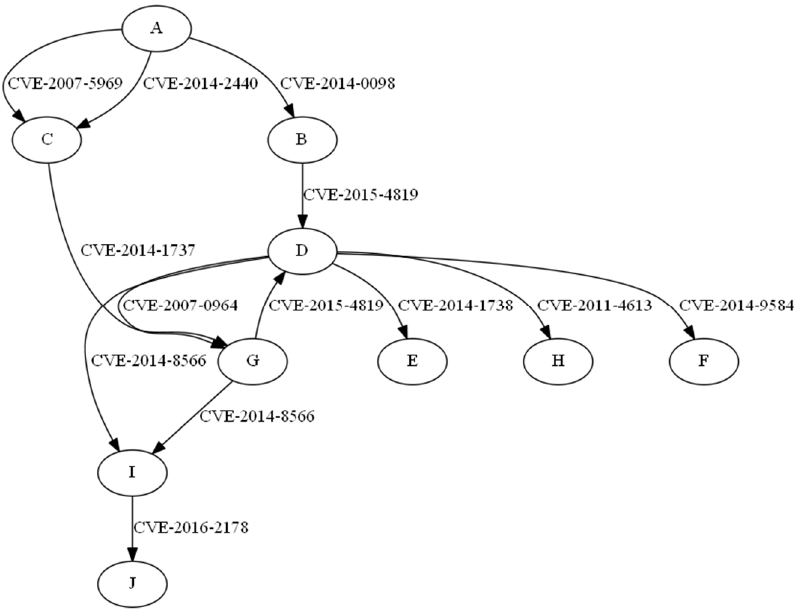
Figure 1. Network that included nodes and vulnerabilities generated in this experiment.